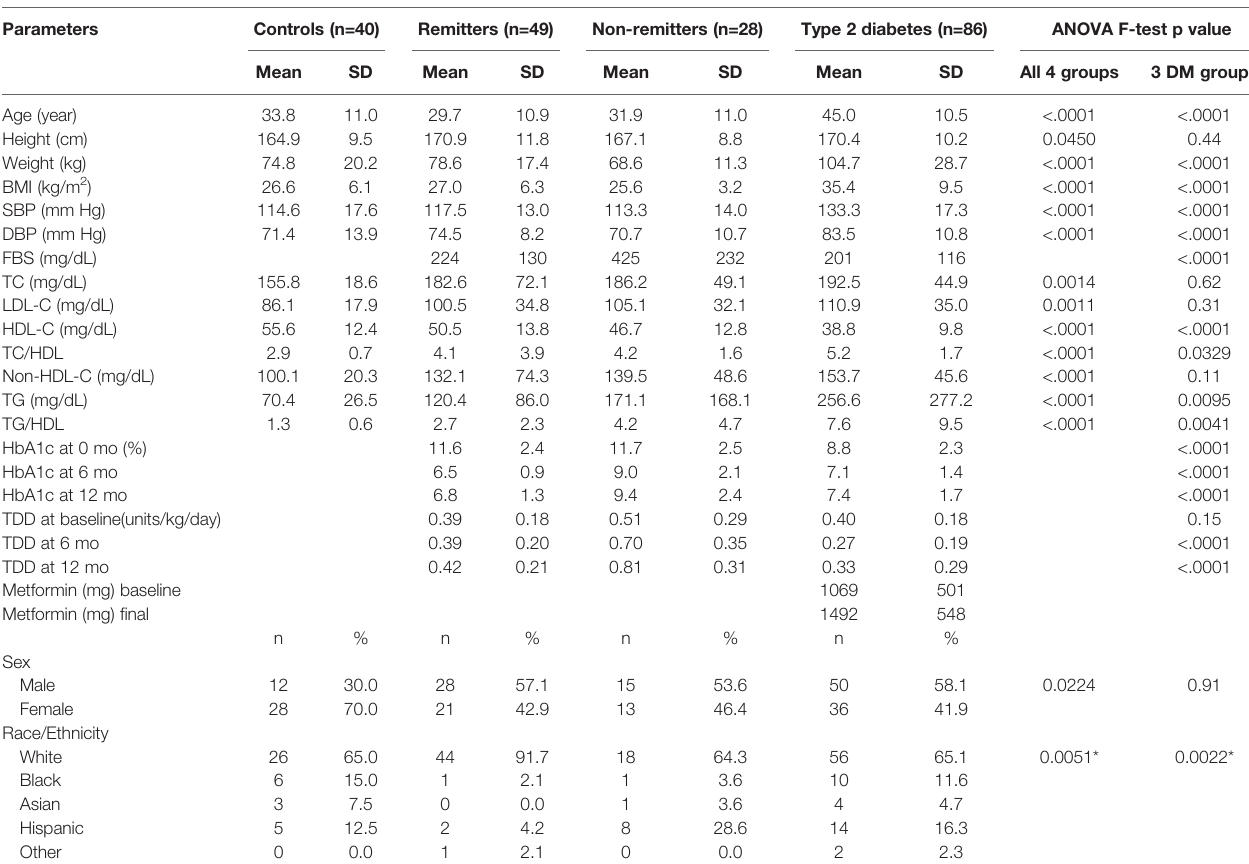
TABLE 1 | Comparison of anthropometric, biochemical, and therapeutic parameters.